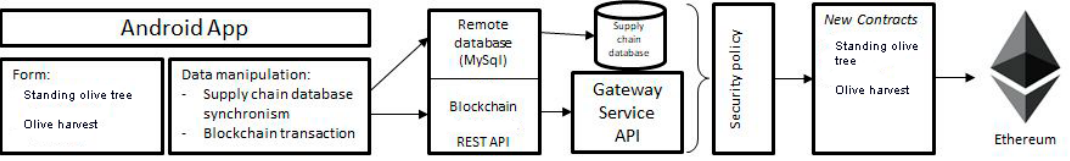
Figure 5. Interconnection diagram between the INFOLIVA app developed and the blockchain.